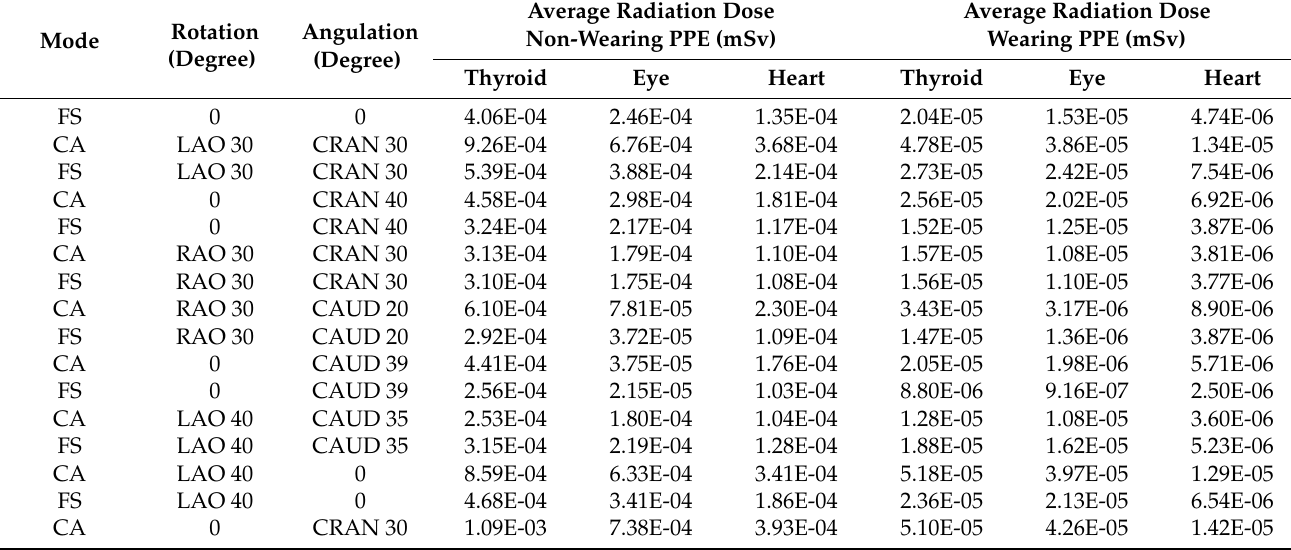
Table 6. The conversion factor for patient air kerma to occupational organ dose in cardiac